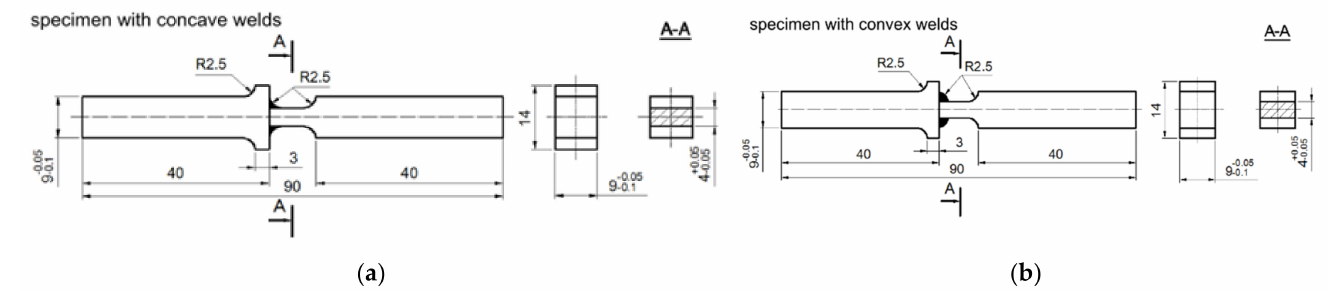
Figure 1. Geometries of specimen: ( a ) with concave welds, ( b ) with convex welds, (dimensions in